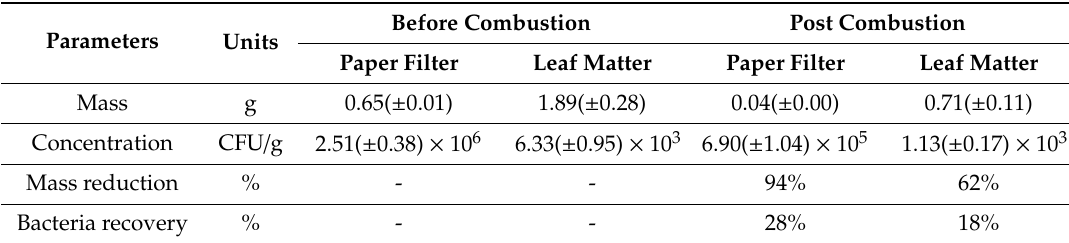
Table 1. Survivability of microorganisms as a result of incomplete combustion of contaminated organic materials. Bacteria recovery rate is calculated using formula